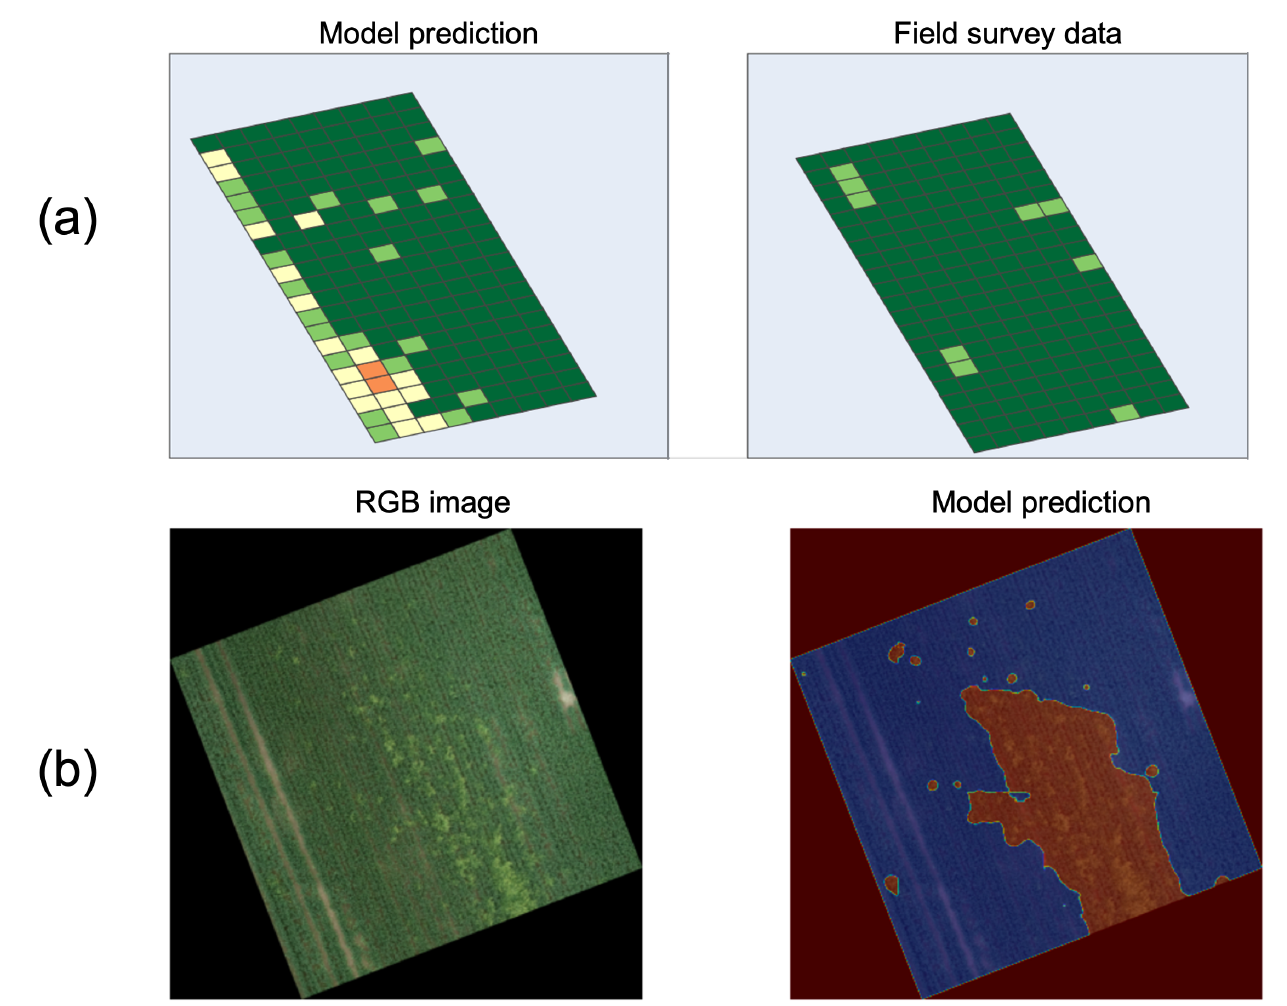
Figure 5. ( a ) Comparison between classification derived from the deep learning model and field survey data for the outlier field in the correlation analysis (dark green: absent; Light green: low; yellow: medium; orange: high; red: very high); ( b ) closer look to one of the quadrats classified as high abundance of weed in ( a ) (e.g., orange) in terms of raw RGB image and related model